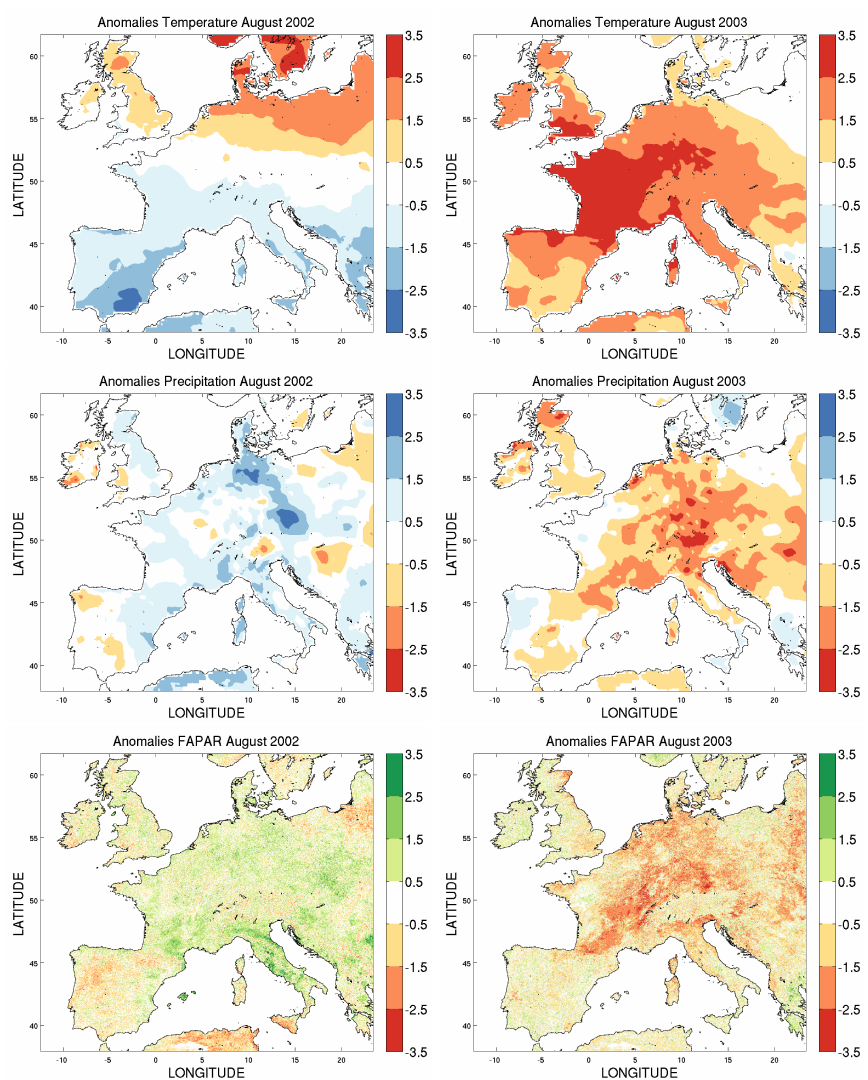
Figure 3. Monthly anomalies of surface temperature, precipitation and FAPAR for the two contrasting wet and dry periods of August 2002 ( left ), and August 2003 ( right ). Anomalies of FAPAR and surface temperature are normalized using Z-scores, i.e. , the departure from the climatological mean is divided by the standard deviation for the given month, hereafter AFAPAR and AT, respectively. Anomalies of precipitation refer to Standardized Precipitation Index (SPI)-3. Deficits and excesses in temperature are represented by shades of red and blue, respectively, while deficits and excesses in precipitation are represented by shades of blue and red. Areas of high and low photosynthetic activity are shown in shades of green and red,